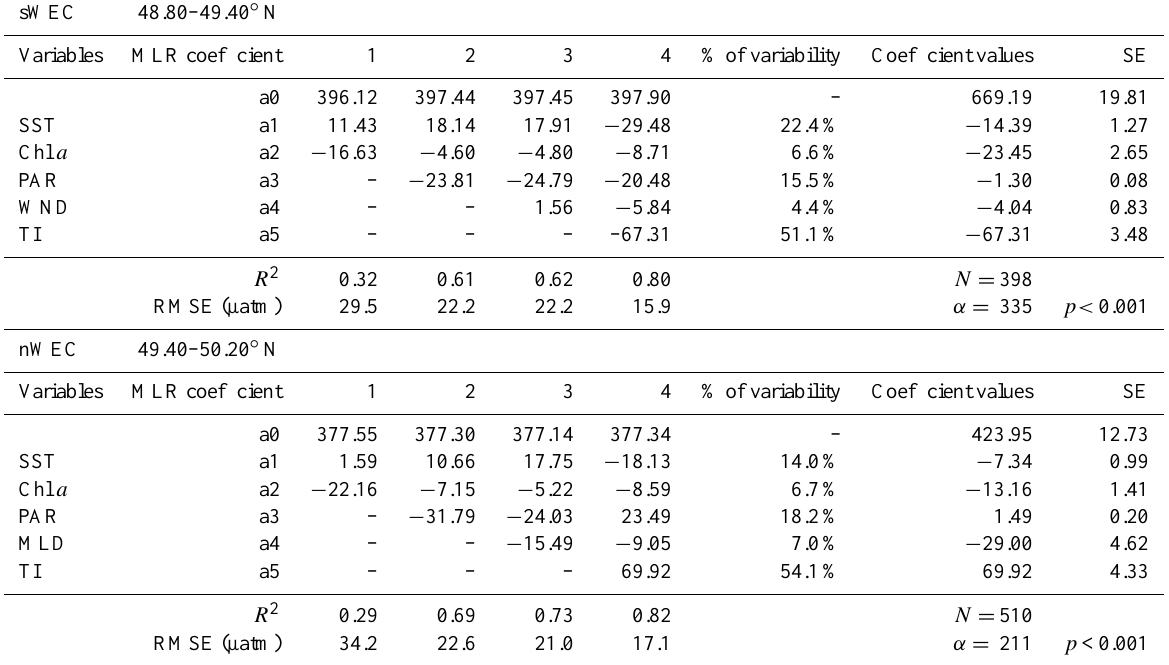
Table 2. MLR-normalized coefficients for each variable in sWEC and nWEC with corresponding R 2 and RMSE values. Percentages of variability explained by each variable were computed only when all the variables were included in the MLR. Non-normalized coefficient values are given for the last step of the MLR with their standard error (SE). N values are the number of values used in the MLR and α is the value between 0 and 365 chosen by iteration to optimize the seasonal